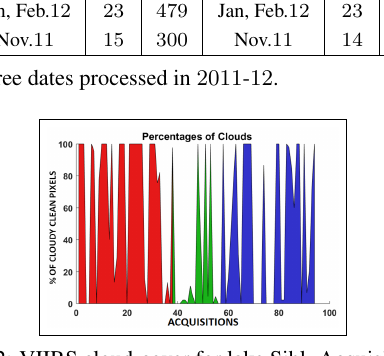
Figure 2: VIIRS cloud-cover for lake Sihl. Acquisitions in October 2016 are shown in red, first half of December 2016 in green and February 2017 in blue. Best viewed on screen.